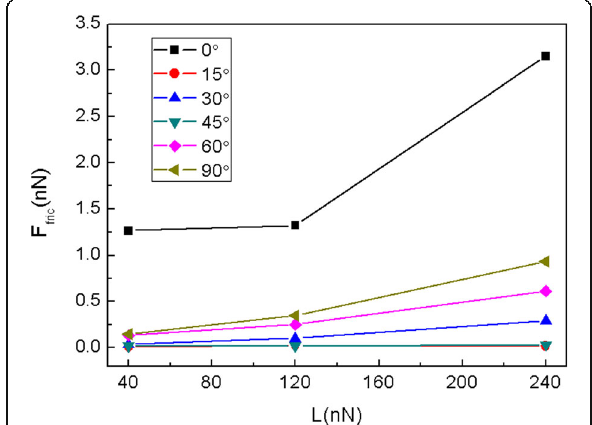
Fig. 6 The average friction force Ffric of the 5.8-nm square flake for different rotation angles at different normal loads